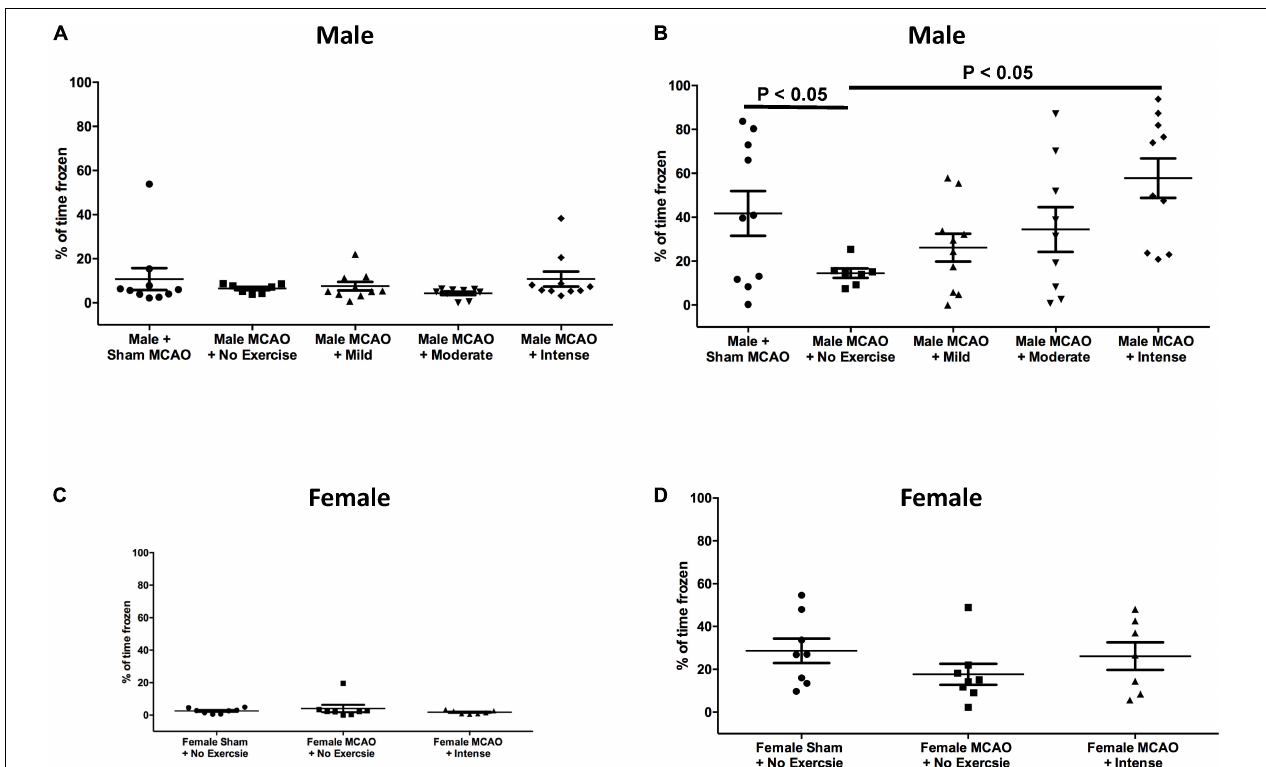
FIGURE 2 | Contextual fear conditioning as a measure of spatial memory performance 3 weeks following MCAO injury in aged male and female rats. (A) Day 1 as a percent of time spent frozen prior to exposure of shock stimulus for aged male rats. There were no significant differences between groups (One way ANOVA, Bonferroni post hoc ). (B) Day 2, 24 h following exposure to shock in the same context for aged males. Animals that underwent intense exercise froze significantly more than animals that received no exercise ( P < 0.05, One way ANOVA, Bonferroni post hoc test). (C) Day 1 as a percent of time spent frozen prior to exposure of shock stimulus for aged female rats (Students t -test). (D) Aged female rats at the same time point with or without intense exercise. There was no observed benefit for aged female